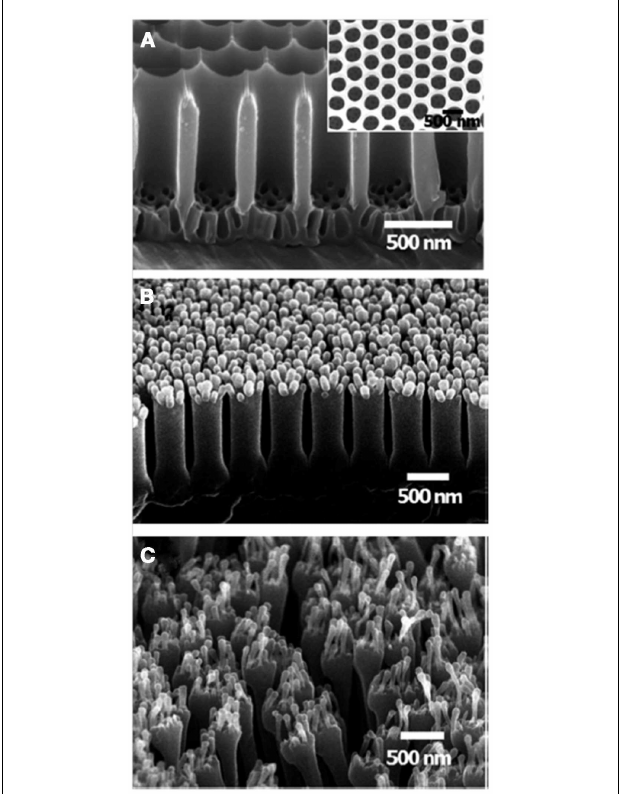
FIGURE 5 | SEM images of (A) the multi-branchedAAO template (inset, top view), (B) the PS nanohairs replicated by removing the template during the wet etching process (denoted DLW), and (C) elongated hierarchical PS nanohairs replicated using the surface-modified template and peel-off process (denoted DL) (tilt angle 45°) . From Lee et al.